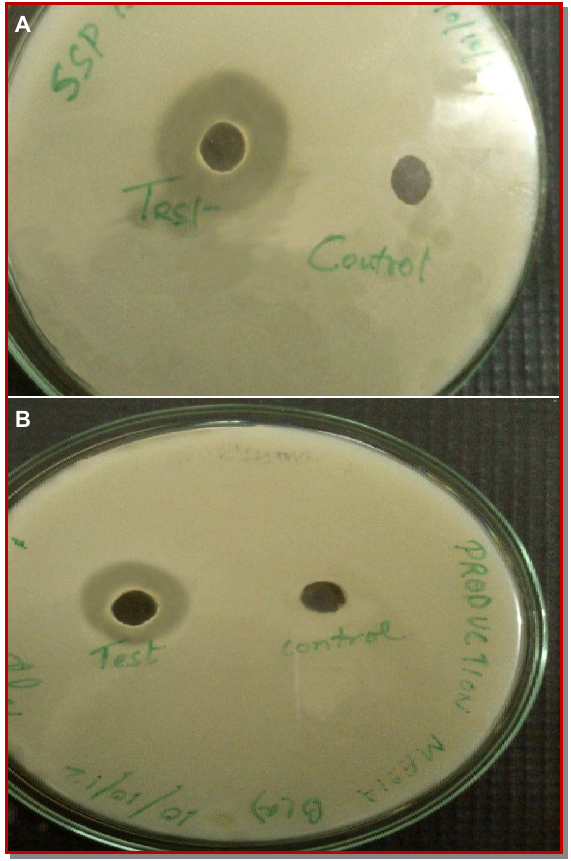
Figure 1: Caseinolytic activity of SFN on production media (A) with shrimp shell or (B) without shrimp shell